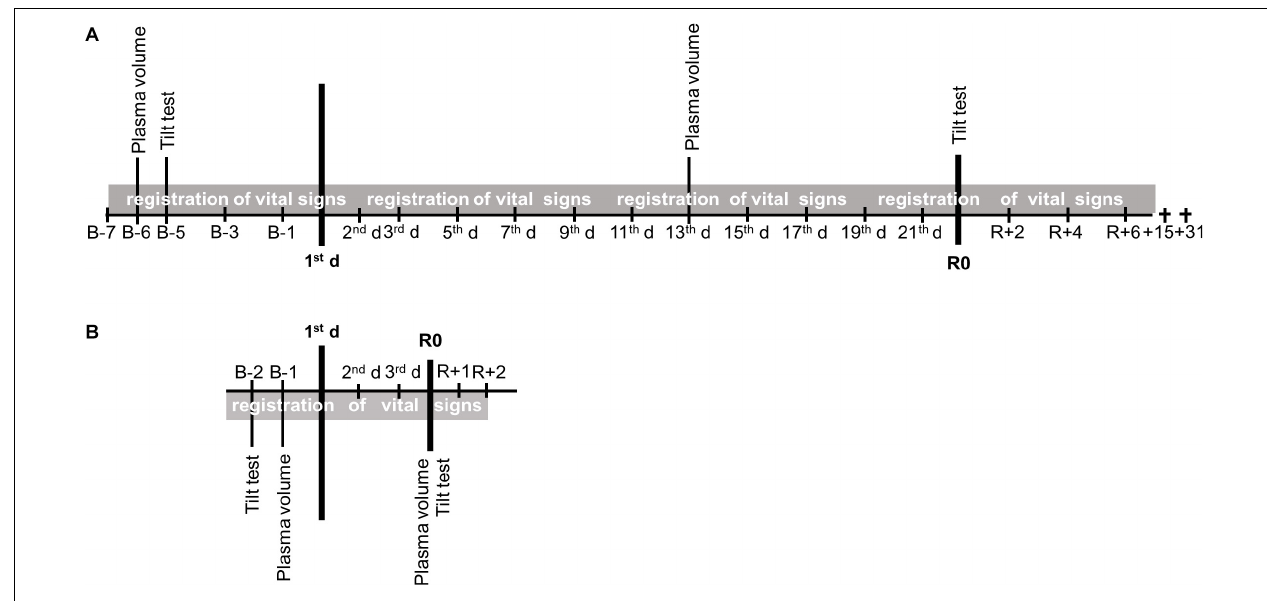
FIGURE 1 | The protocols. (A) 21-day head-down bed rest (HDBR). (B) 3-day dry immersion (DI).